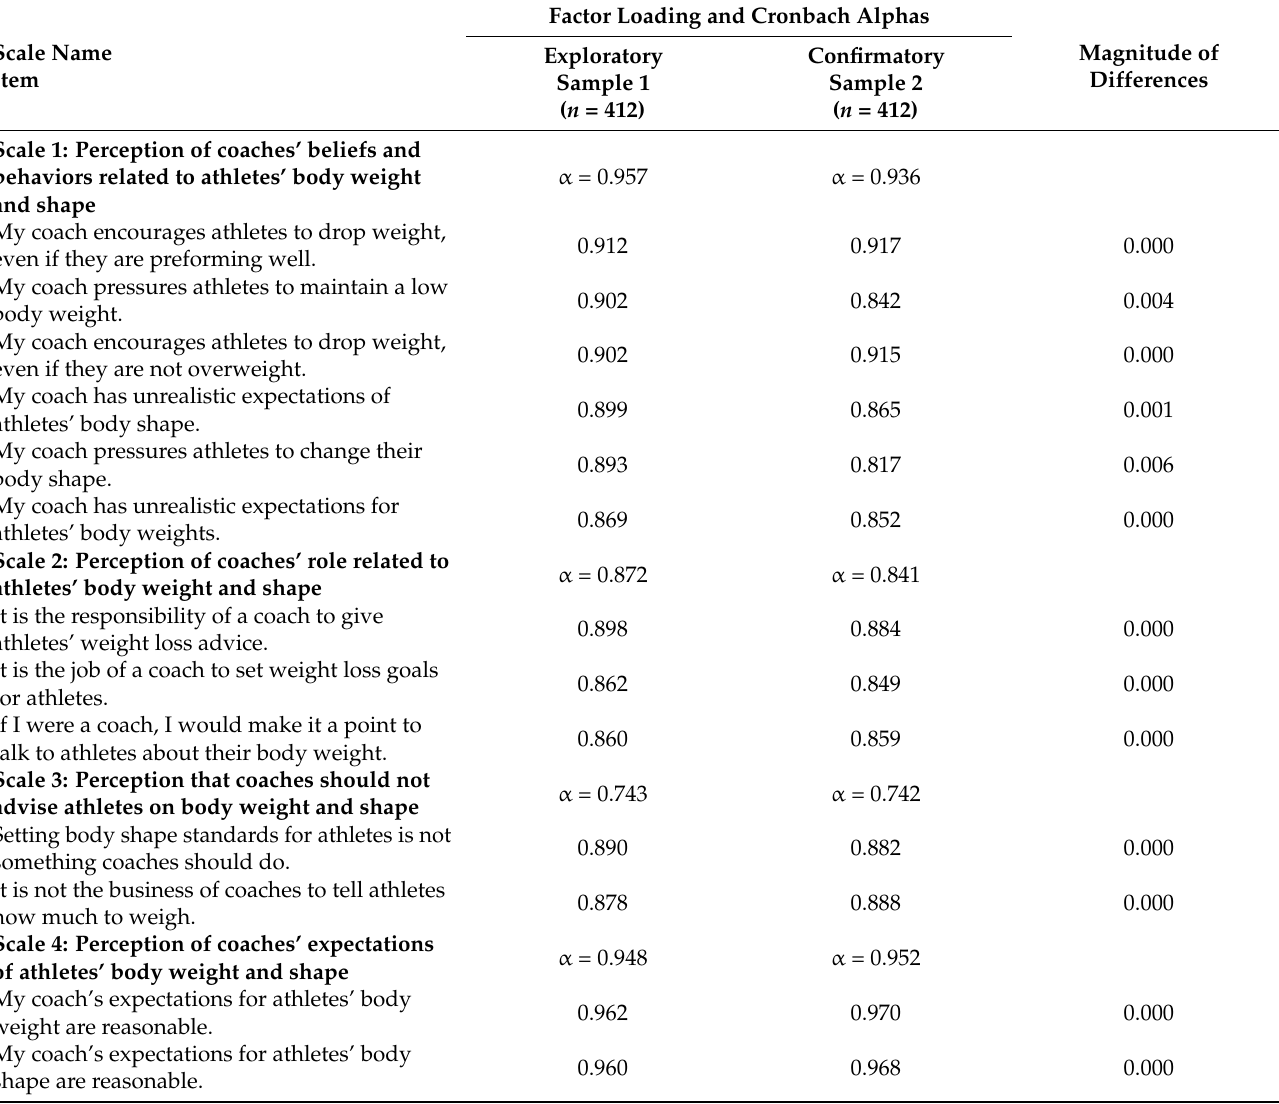
Table 2. Exploratory and Confirmatory Factor Loadings and Magnitude of Differences for Females’ Responses to Athletes’ Perceived Body Pressures from Coaches Questionnaire.